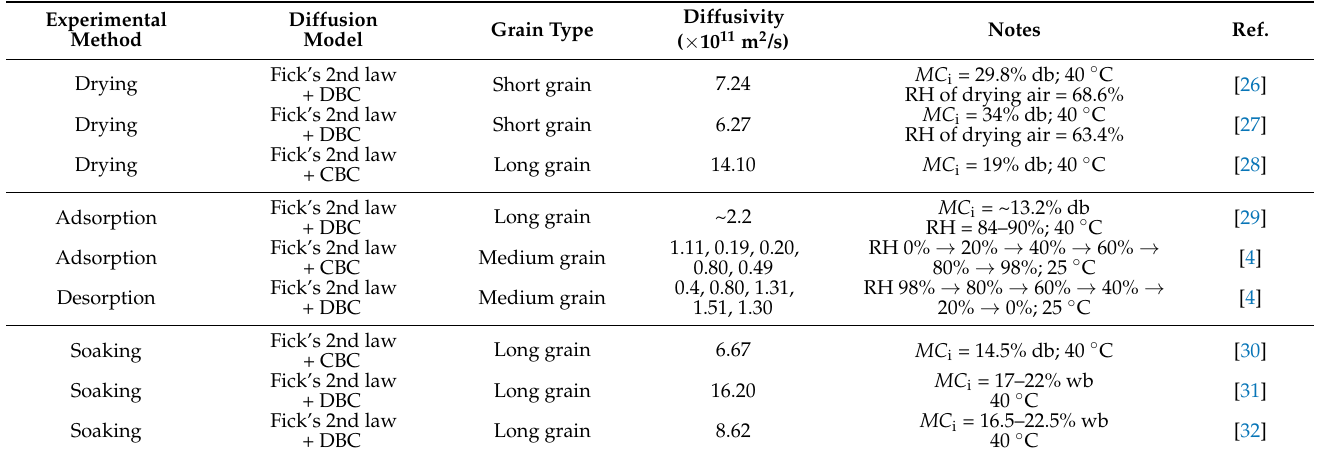
Figure 2. Water di ff usivities in glutinous rice grains during adsorptions and desorptions with dif- Figure 2. Water diffusivities in glutinous rice grains during adsorptions and desorptions with ferent RH step sizes obtained according to Fick’s second law. different RH step sizes obtained according to Fick’s second law. Table 2. Reported e ff ective di ff usivity values of water in rice endosperm. Table 2. Reported effective diffusivity values of water in rice